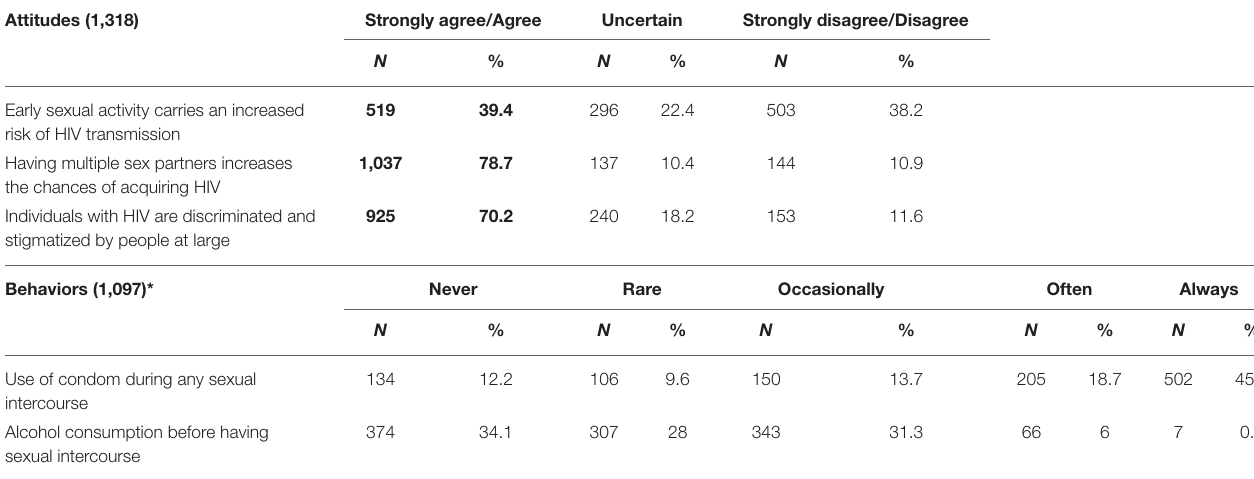
TABLE 3 | Respondents’ attitudes toward HIV infection and self-reported sexual